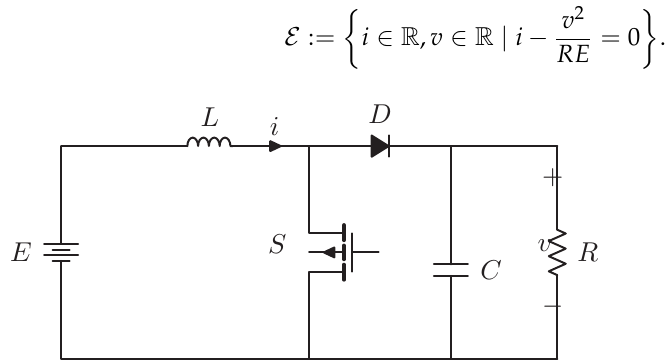
Figure 2. The circuit topology of DC–DC boost